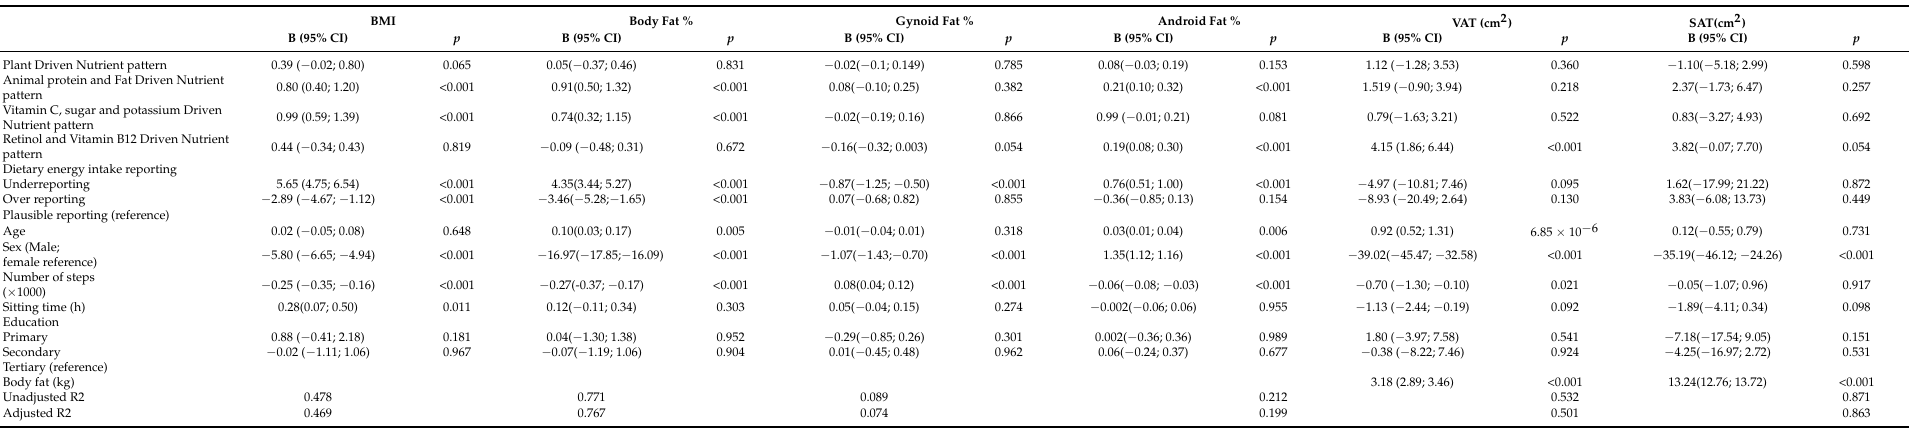
Table 3. Regression coefficients for 1 SD increase in the derived nutrient pattern scores for selected body composition